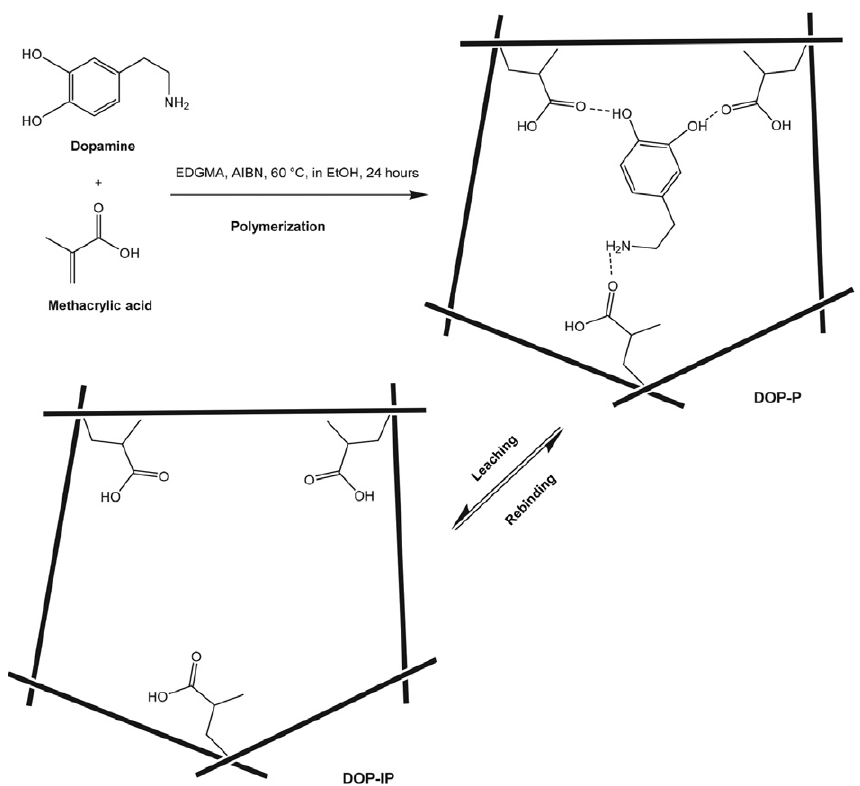
Figure 1. Schematic representation of the DOP-IP preparation